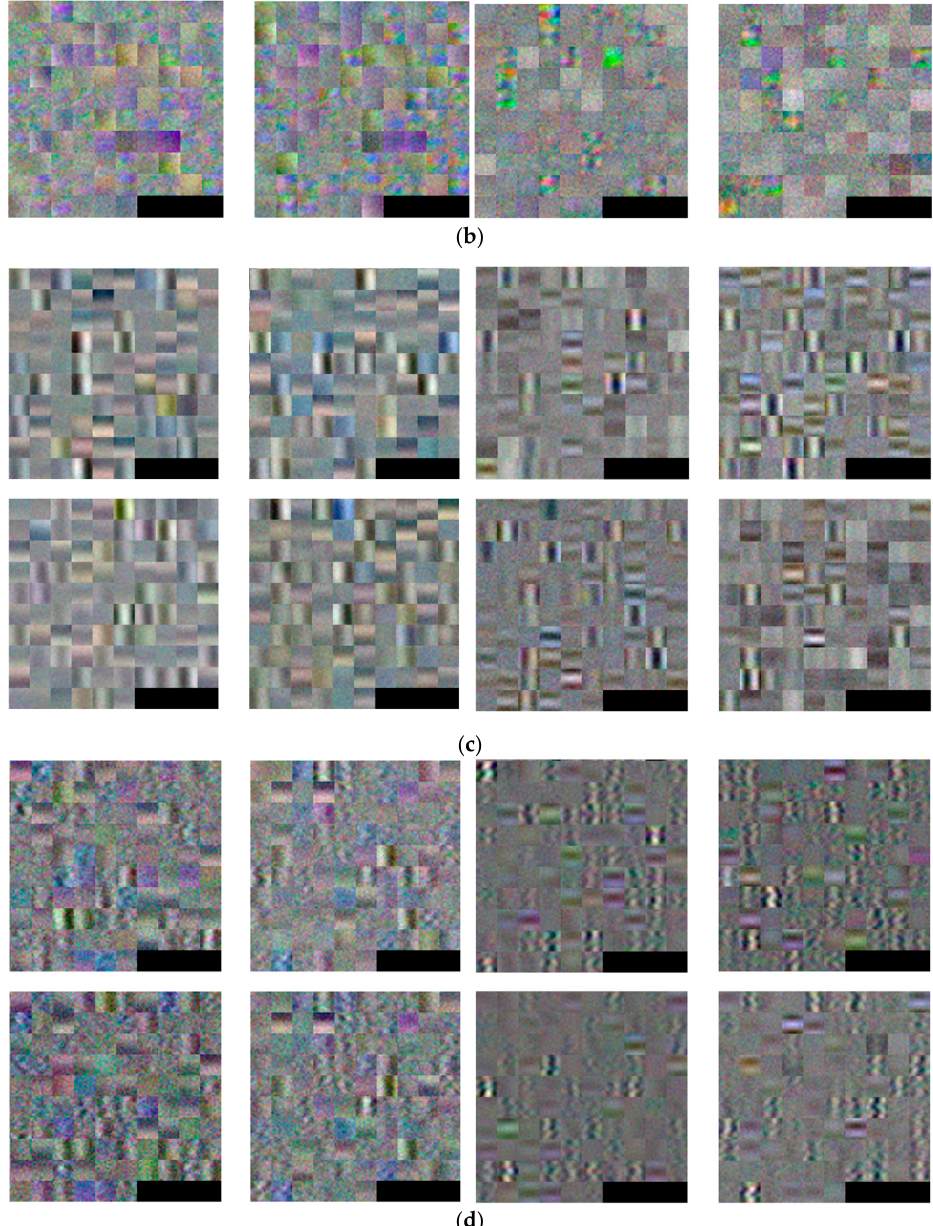
Figure 5. Examples of 96 filters obtained from 1st convolution layer through training: ( a ) CVC-14 database; ( b ) DNHD-DB1; ( c ) KAIST database; and ( d ) combined database. In ( a – d ), the left four images show the 96 filters obtained by training with the original images, whereas the right four images represent those obtained by training with the HE images. In the left and right four images, the left-upper, right-upper, left-lower, and right lower images show the 96 filters obtained by training using 1-, 2-, 3-, and 4-fold cross validation, respectively. Looking at the 96 filters obtained from the original images in the KAIST database on the left side of Figure 5c, we can see that there is relatively little noise, and there is a marked contrast between the left and right or up and down directions in the filters compared to the 96 filters obtained from the original images of the CVC-14 and DNHD-DB1 databases in Figure 5a,b, respectively. From